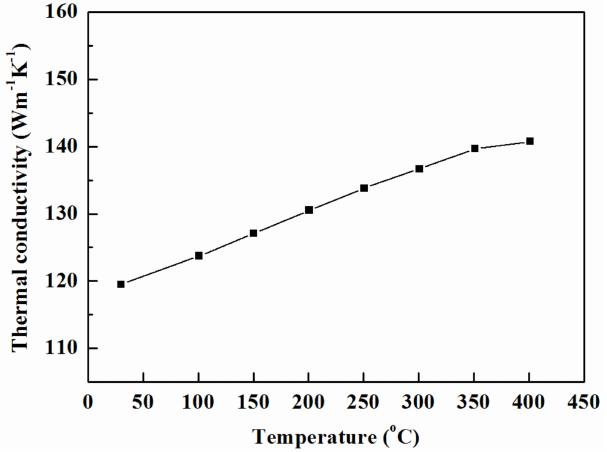
Figure 7. Thermal conductivity of Mg–25%Cu–15%Zn alloy vs.